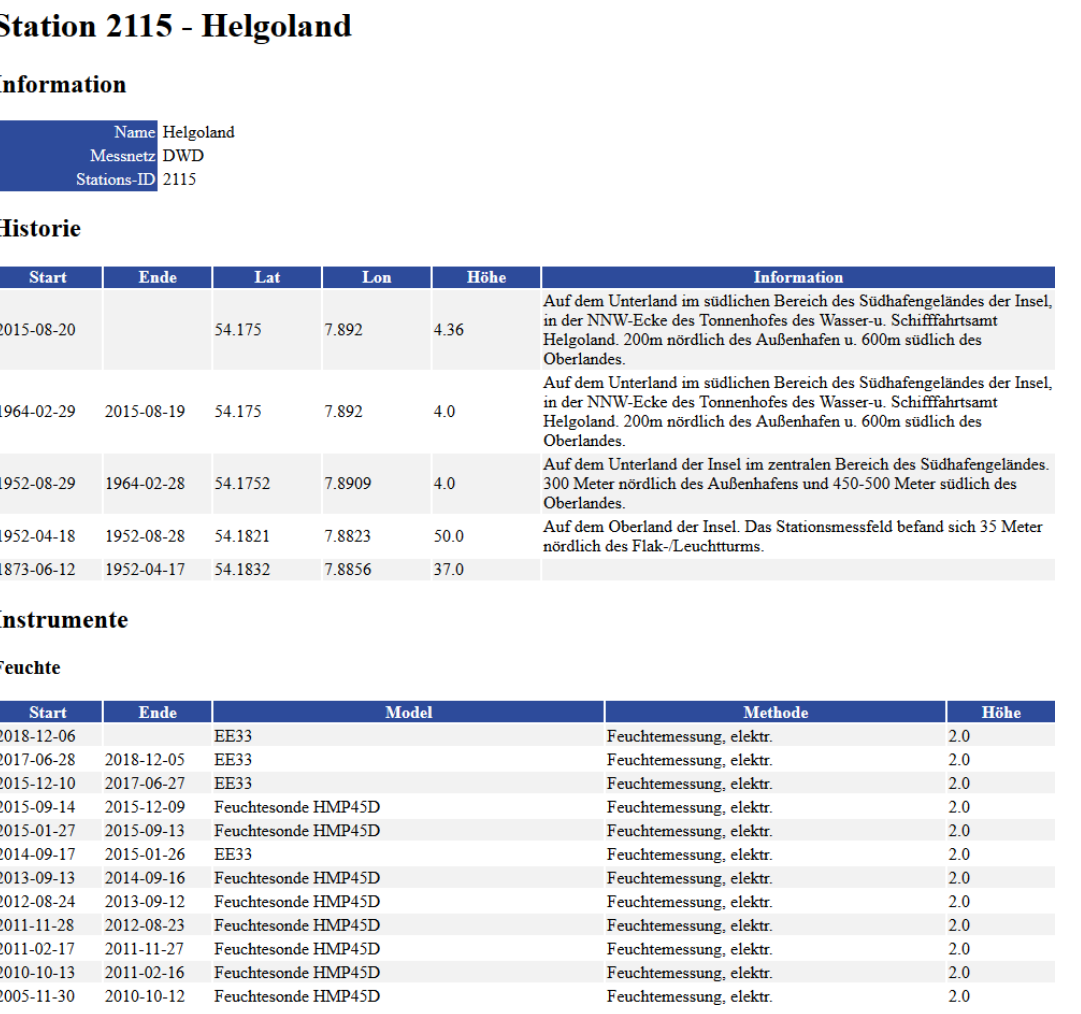
above/below thresholds, or to select stations based on